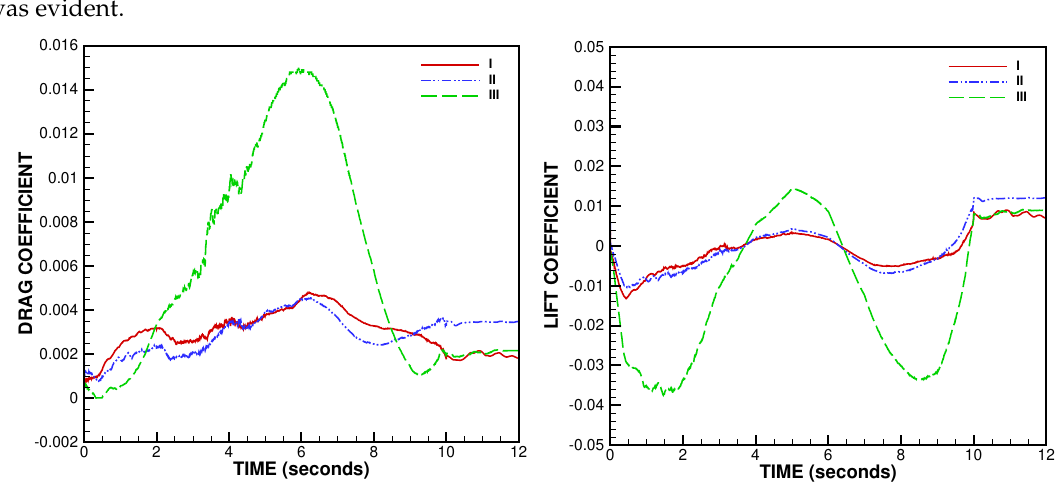
Figure 12. NLG: time history of drag and lift coefficients for the downwind front door.